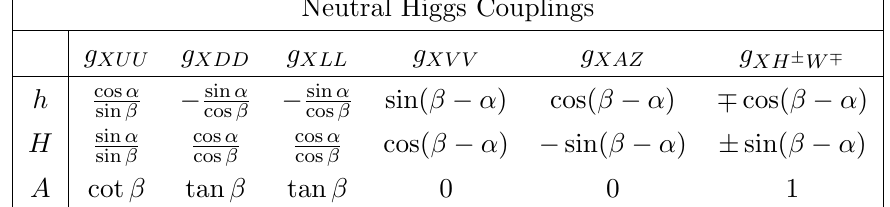
Table 5 . The SM-value normalized couplings of the neutral Higgs bosons at the tree level. The up- type quarks, the down-type quarks, the leptons, the vector bosons and the neutral Higgs bosons are represented by U , D , L , V and X , respectively. The couplings of A to fermions are the pseudo-scalar type and the others are the scalar